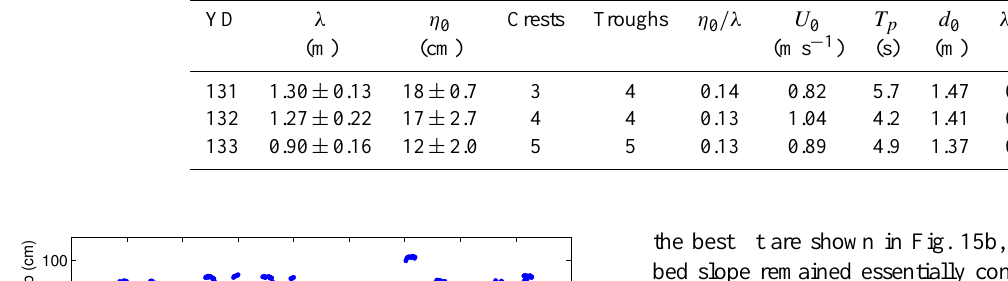
Table 1. Ripple properties and associated wave forcing parameters.